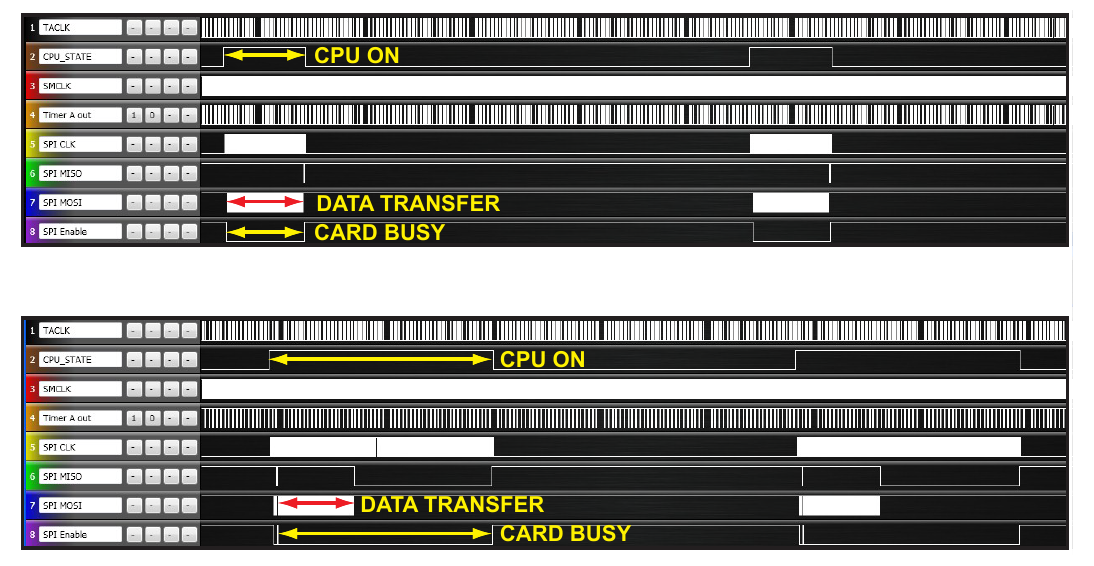
Figure 9. Single vs . multiple block write